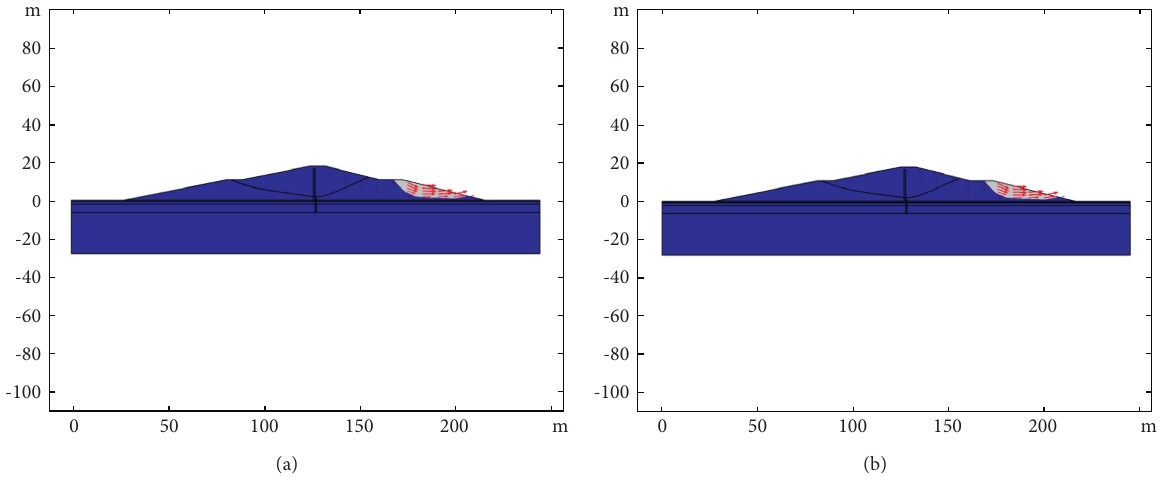
Figure 12: The most dangerous slip surface of the cofferdam under (a) flood level and (b) low water